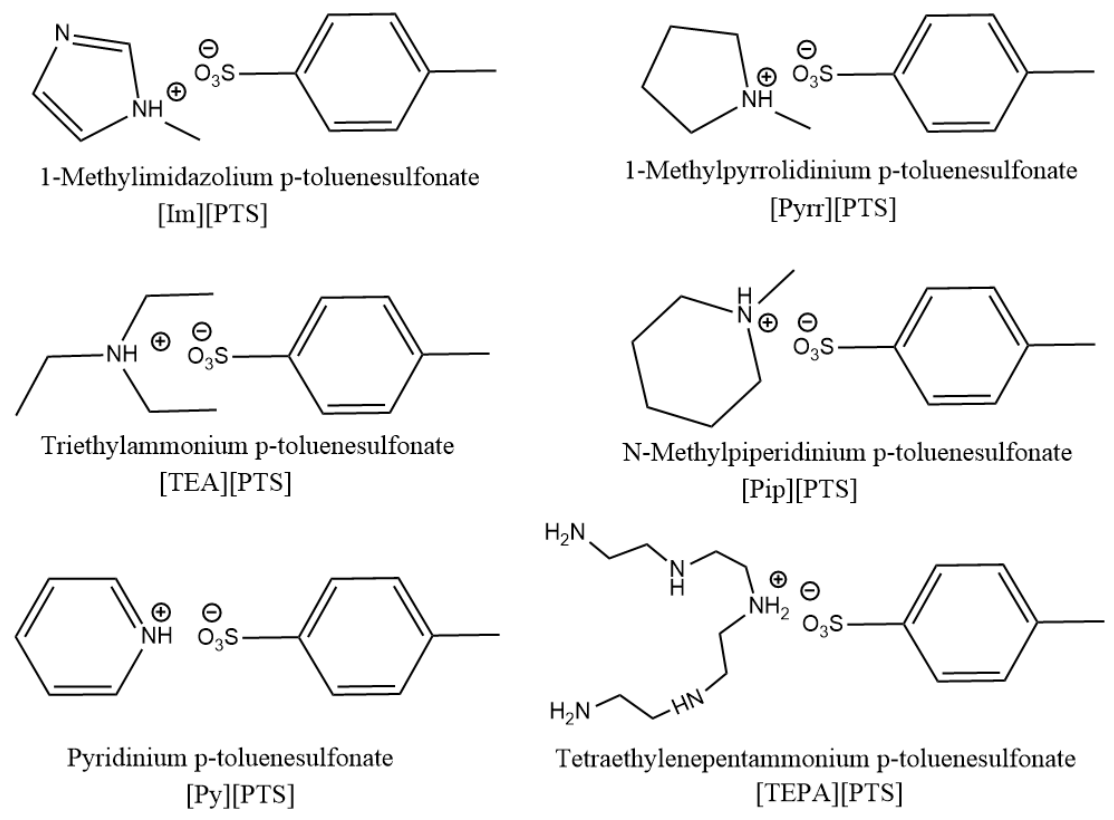
Figure 1. Structures of the 6 synthesized protic ionic liquids (PILs) based on p-toluene sulfonate anion [PTS].